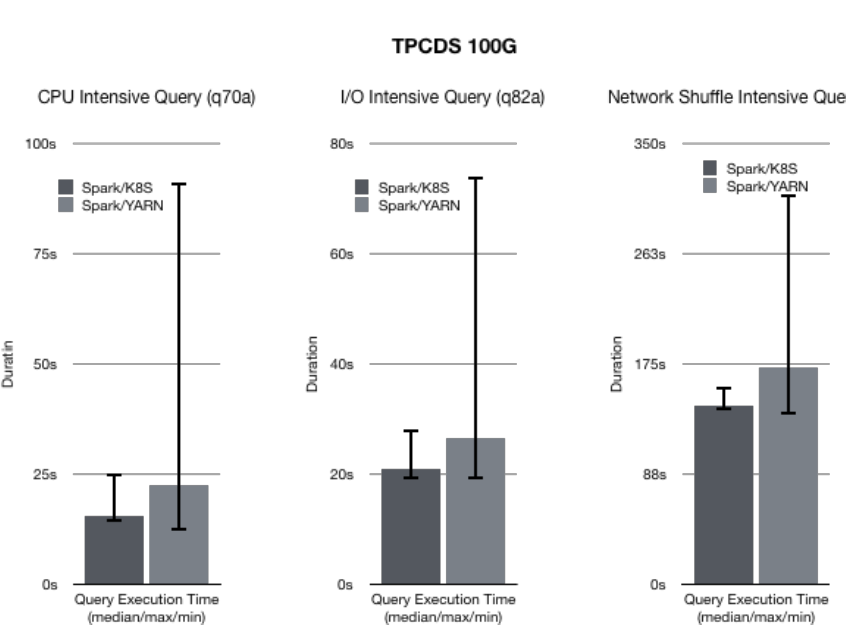
Figure 8: Client tools to manage Spark Kubernetes cluster Figure 9: Elapsed time of selected queries executed against YARN &